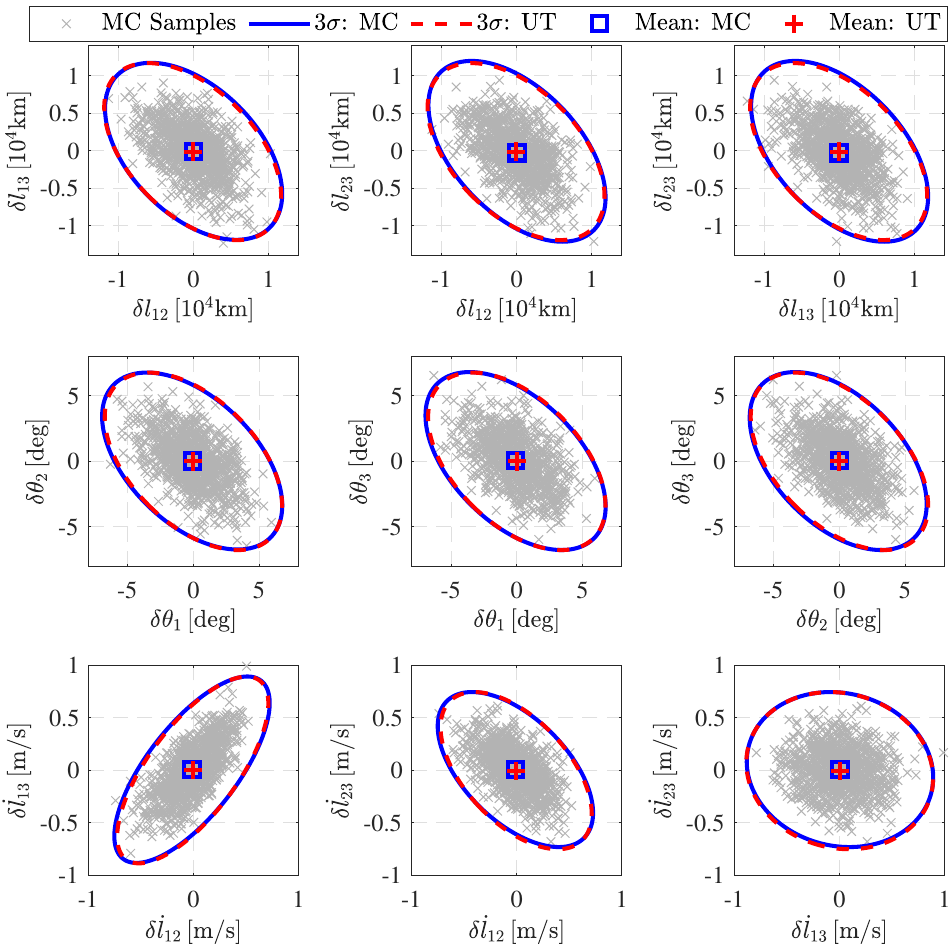
Figure 7. Comparison of the distribution of the stability indexes predicted by the UT ( κ = 9) and the Monte Carlo simulation. The blue lines and the red dashed lines respectively represent the 3 σ bounds predicted by the MC simulation and UT